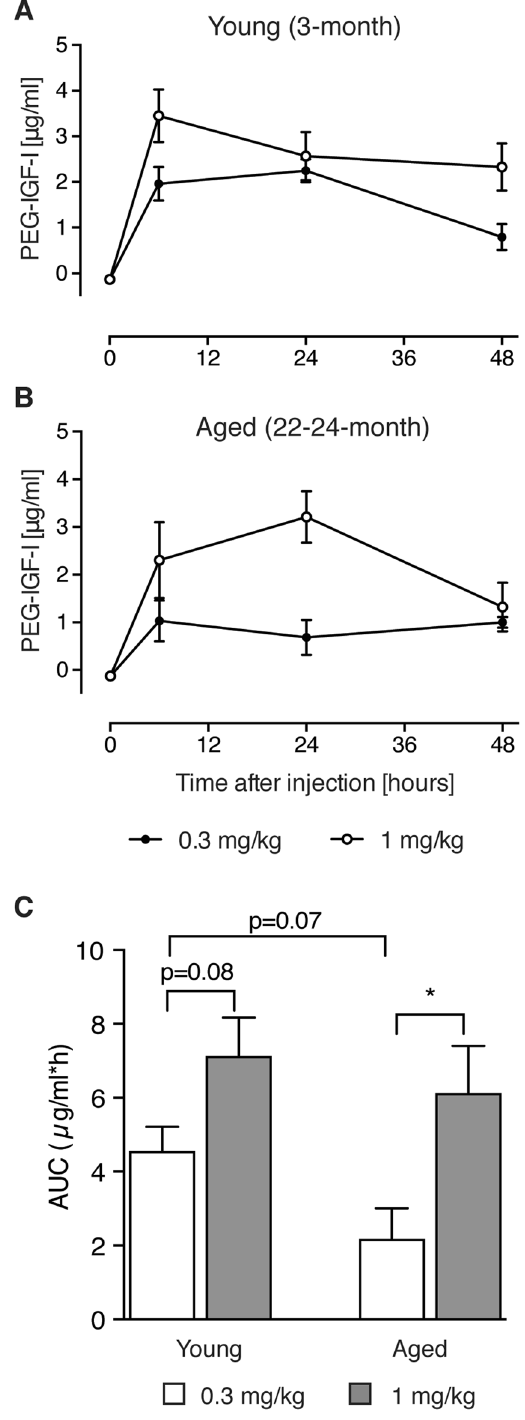
Figure 1. Serum concentrations of PEG-IGF-I were assessed following a single injection of either 0.3 mg/kg, or 1 mg/kg dose in young ( A ) and aged ( B ) mice. Levels could be detected in both young and aged mice even 48 hrs post-injection with levels being slightly higher in the young. ( C ) Areas under curve (AUC, µ g/ml * h) of the pharmacokinetic profiles of PEG-IGF-I treatment over 48 hrs. * p < 0.05 by t-test. An n = 4 per dose and time point was